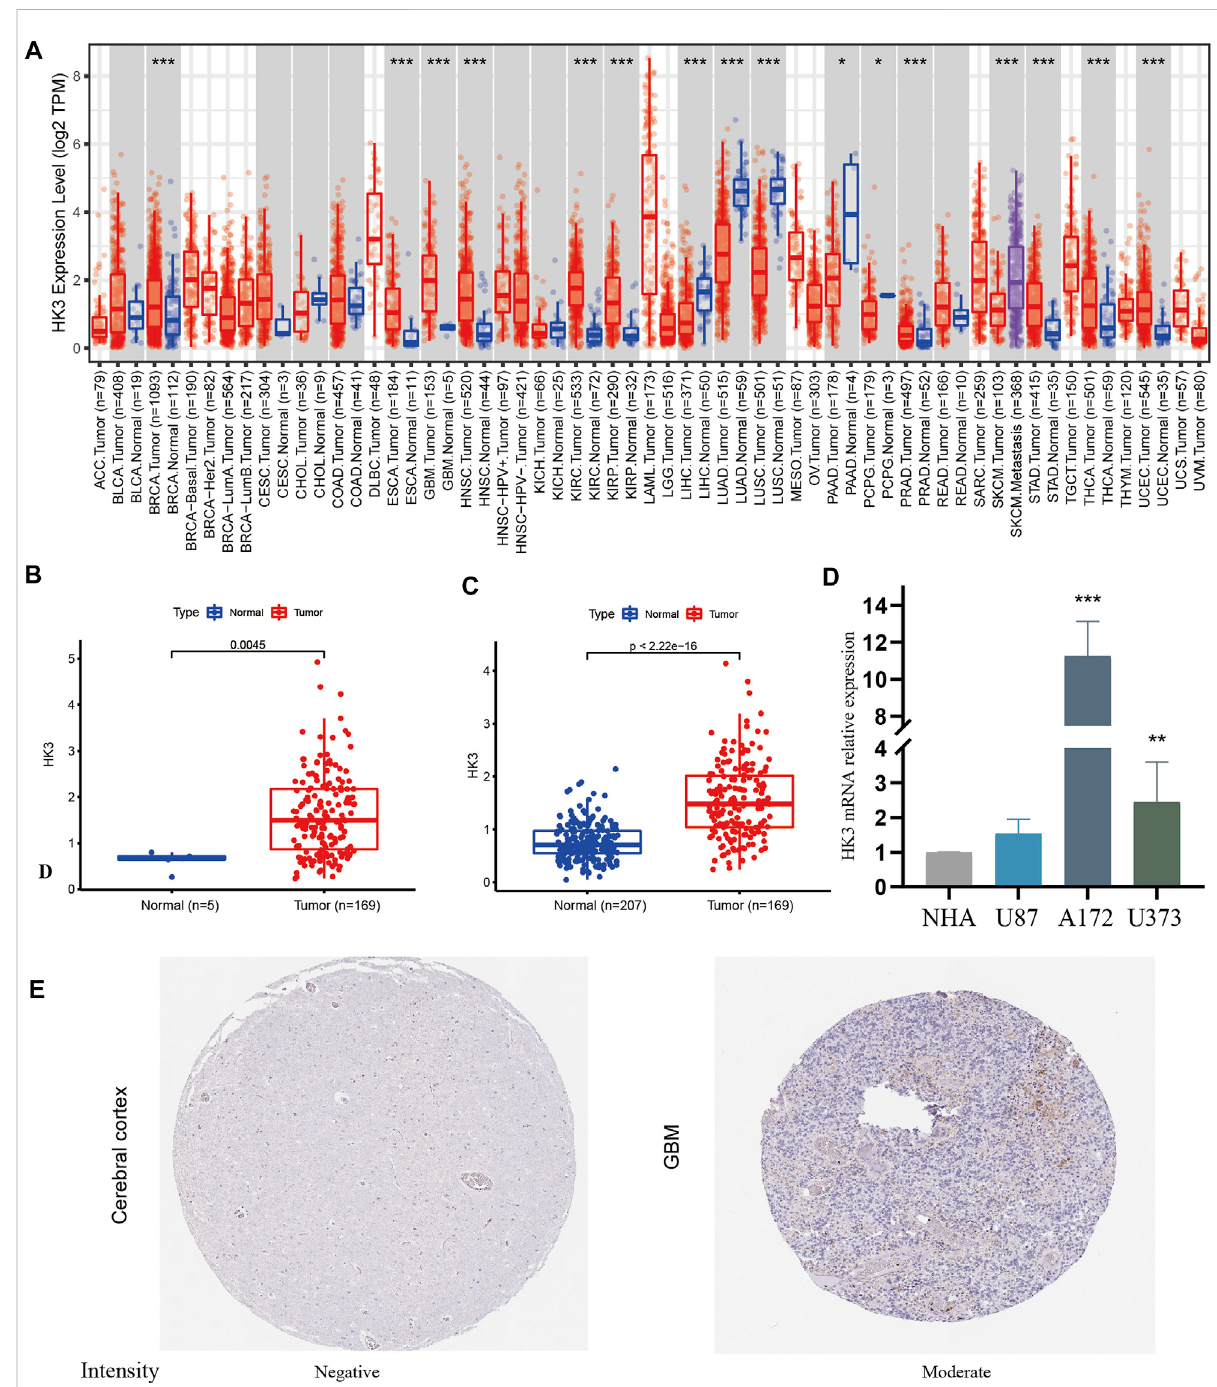
FIGURE 1 HK3expressionincancers. (A) HK3expressionbetweentumorandnormalsamplesatthepan-cancerlevelbytheTIMER2.0; (B) HK3expression between GBM and normal samples in the TCGA-GBM; (C) HK3 expression between GBM samples (TCGA-GBM) and normal samples (GTEx). (D) HK3 mRNA expression between NHA cells and U87, A172, and U373 cells; (E) Protein encoded by HK3 between GBM and normal tissue in the HPA (* p < .05; ** p < .01; *** p <